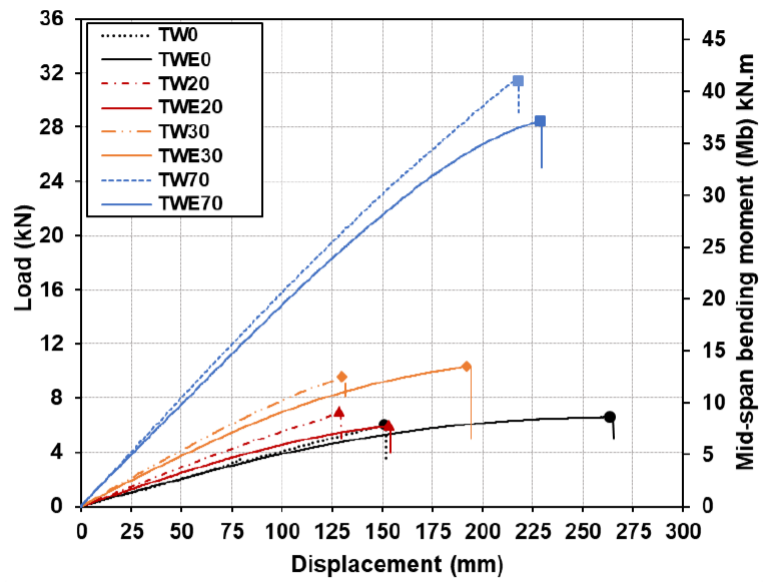
Figure 6. Deflection responses with load and midspan bending moment for TWE specimens in comparison with TW specimens without environmental exposure from [45,46].